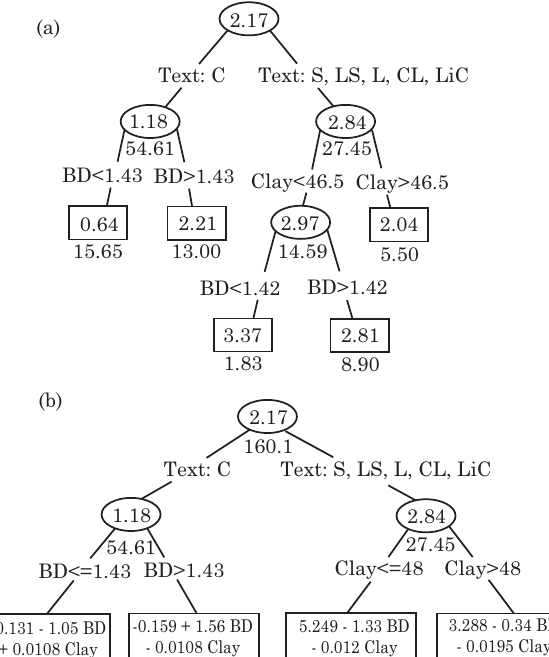
Figure 3. (a) A regression tree to predict saturated hydraulic conductivity (Ksat) from field texture grade (S: sand, LS: loamy sand, L: loam, CL: clay loam, LiC: Light clay, C: clay), bulk density (BD), and clay content. Values in nodes are the predicted log10(Ksat) (in mm/day), values underneath the nodes are the standard deviation of prediction. (b) A hybrid regression tree with continuous piecewise functions (McBratney et al.,